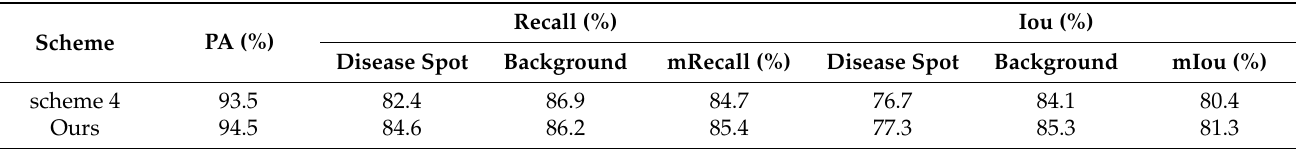
Table 5. Detailed comparison results of segmentation accuracy.